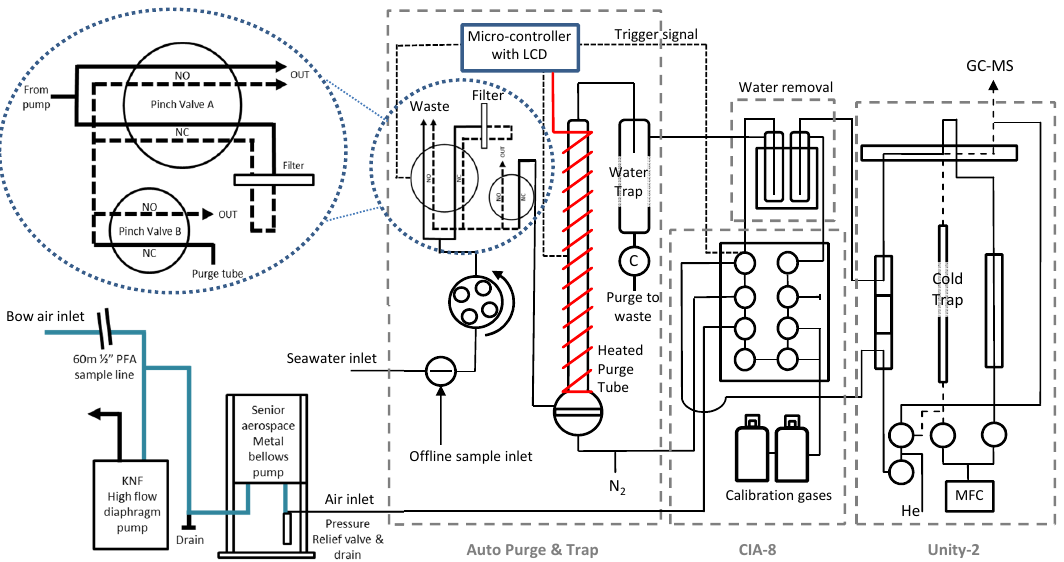
Figure 1. Flow path schematic of the AutoP&T TD-GC-MS system with the “coldfinger” water removal system. Red lines represent electrical connections. Expanded circle: water sample flow paths through the two three-way pinch valves used to automate the purge and trap process. Bottom left: pressurised air sample introduction from the bow